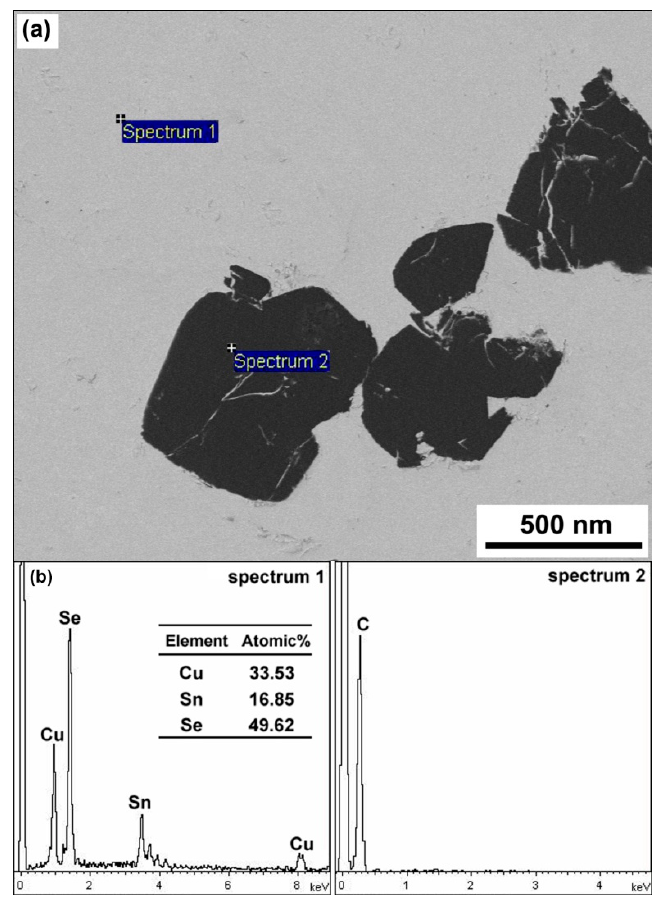
Figure 4. ( a ) SEM microstructure of the sintered pure Cu 2 SnSe 3 ; ( b ) SEM microstructure of sintered 1.6 vol % C 60 /Cu 2 SnSe 3 composite.